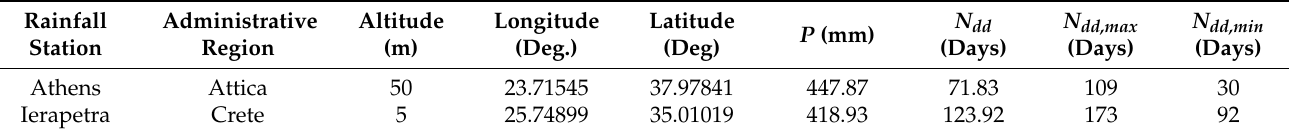
Table 2. Rainfall station characteristics, mean annual rainfall values ( P ), mean, max. and min. values of the longest annual